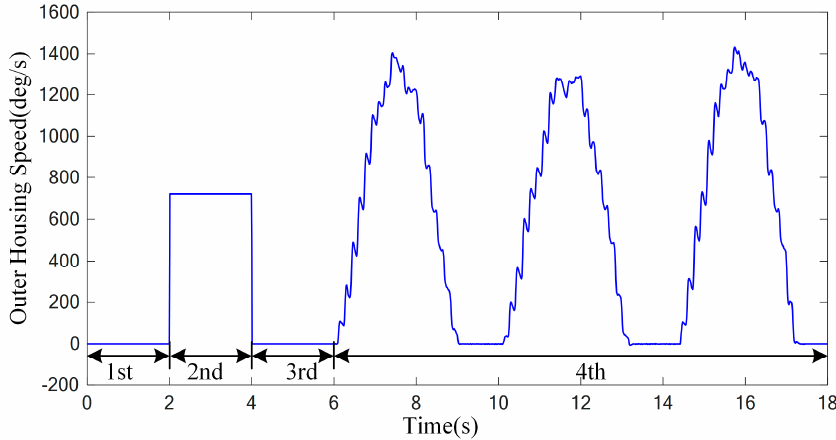
Figure 10. The outer housing speed disturbance.